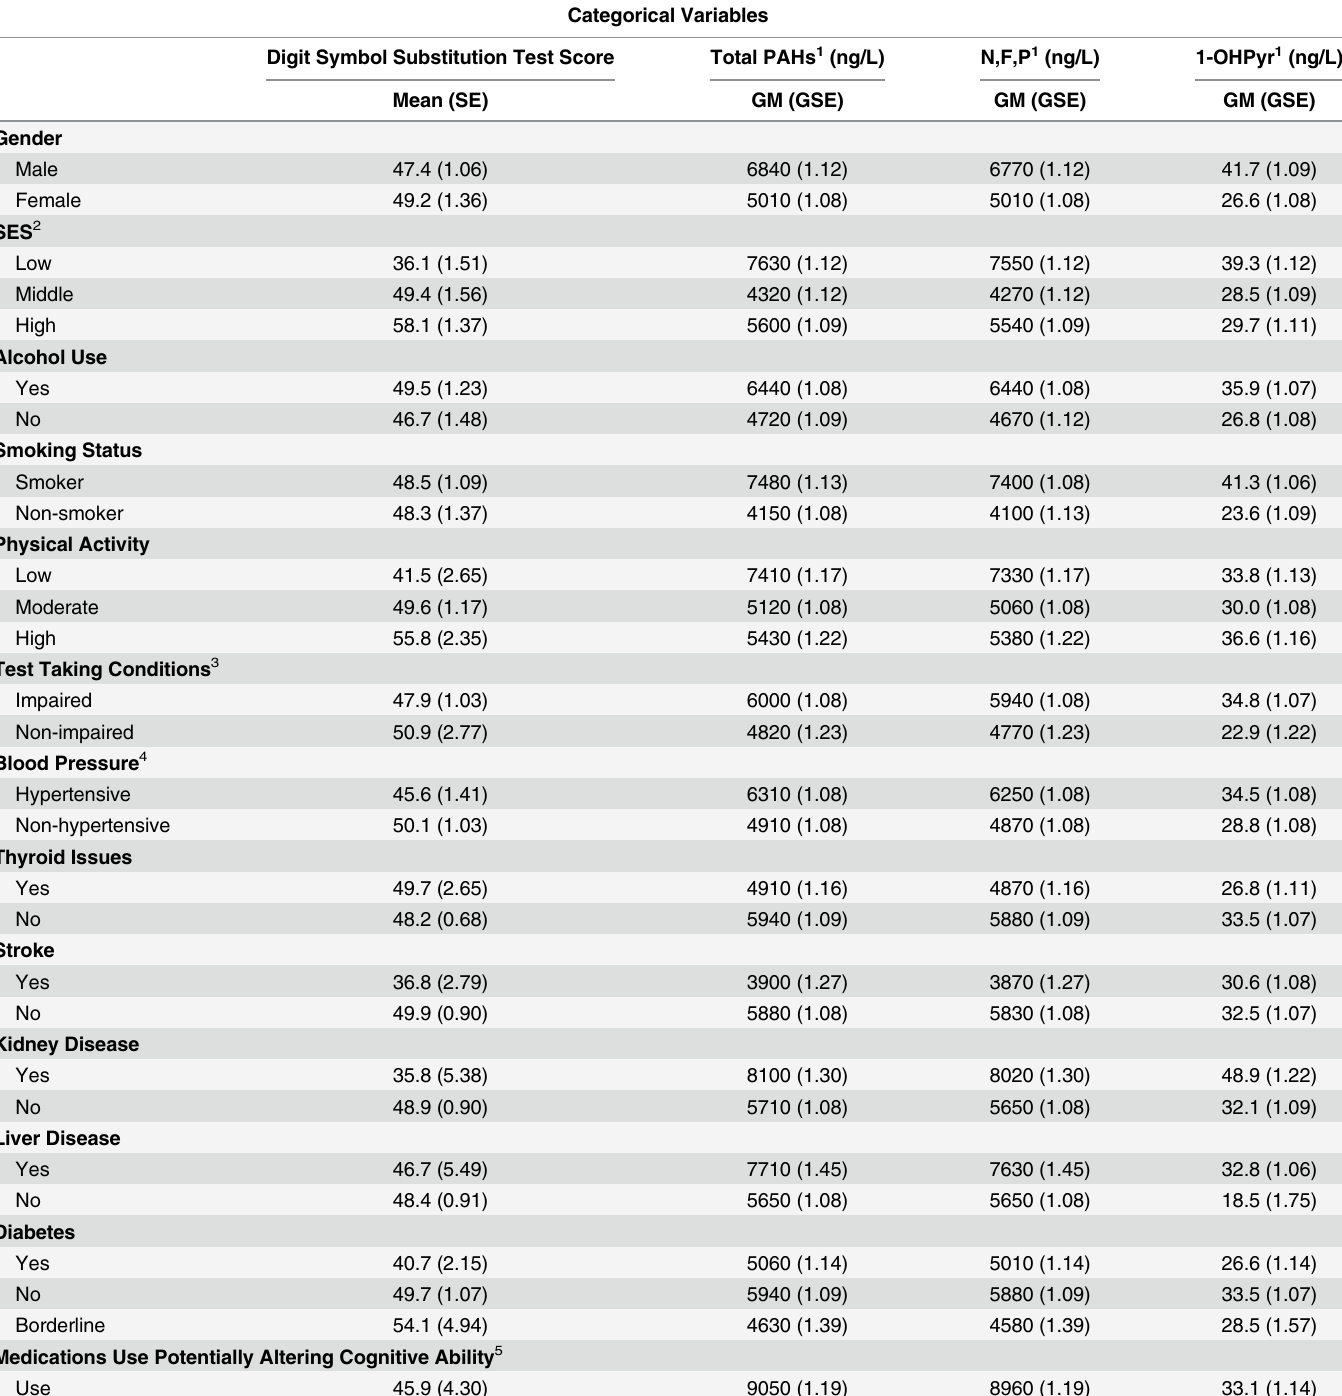
Table 3. Means and Standard Errors for Categorical Variables by DSST and PAH Metabolite Groupings. Categorical